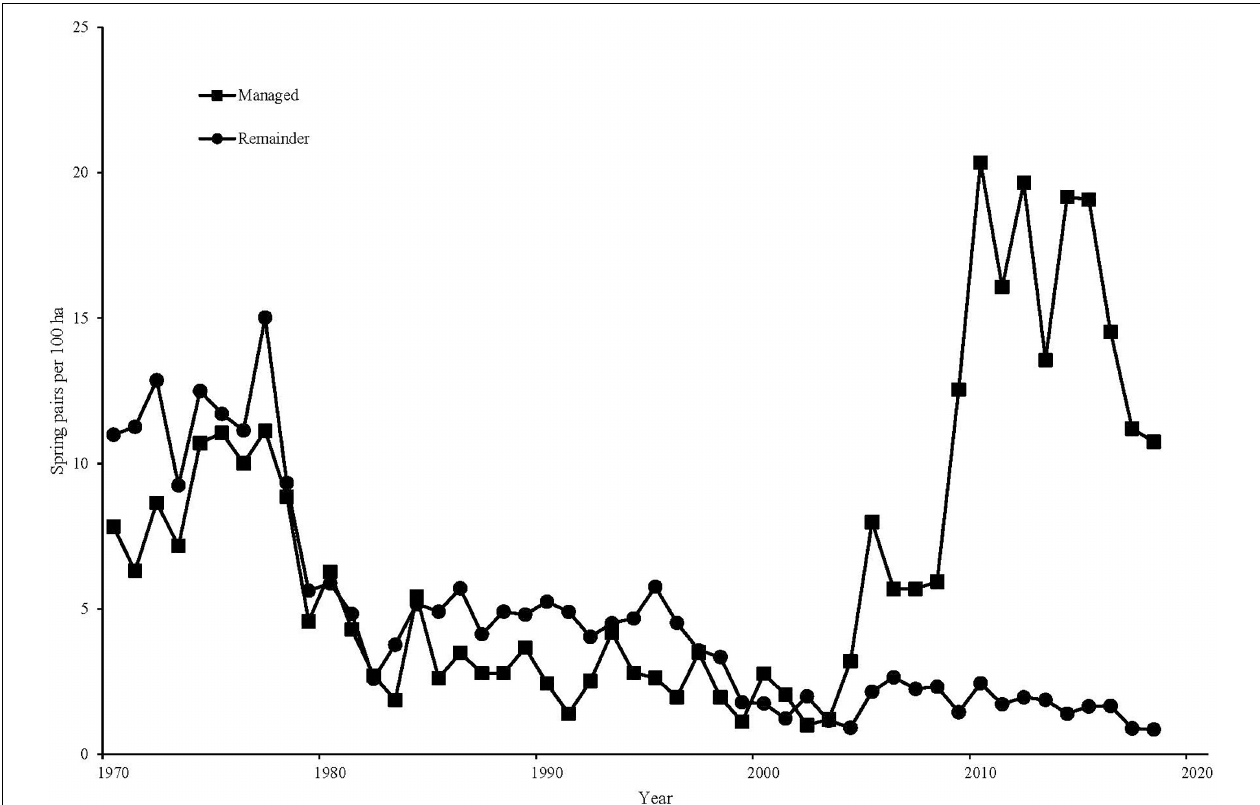
FIGURE 3 | Spring pair counts (pairs/100 ha) of gray partridges, on the GWCT’s Sussex Study area, 1970–2018. Squares represent the land specifically managed for gray partridges from the mid-2000s. Circles represent land not subjected to partridge-specific management.